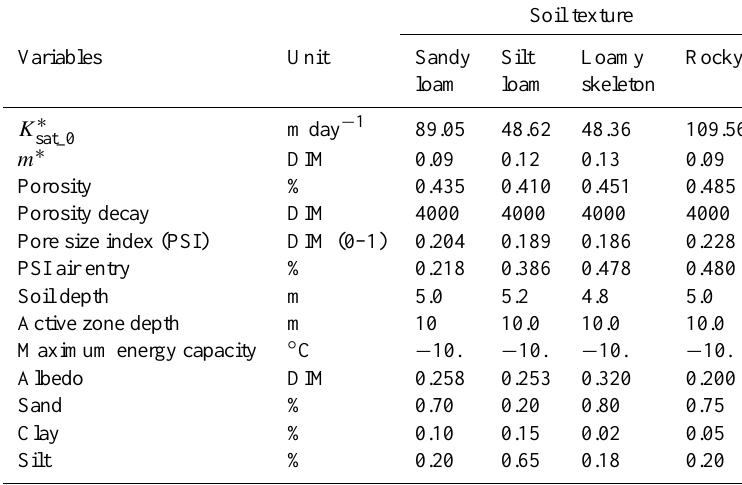
Table 1. Major soil parameters and their parameterizations used in this